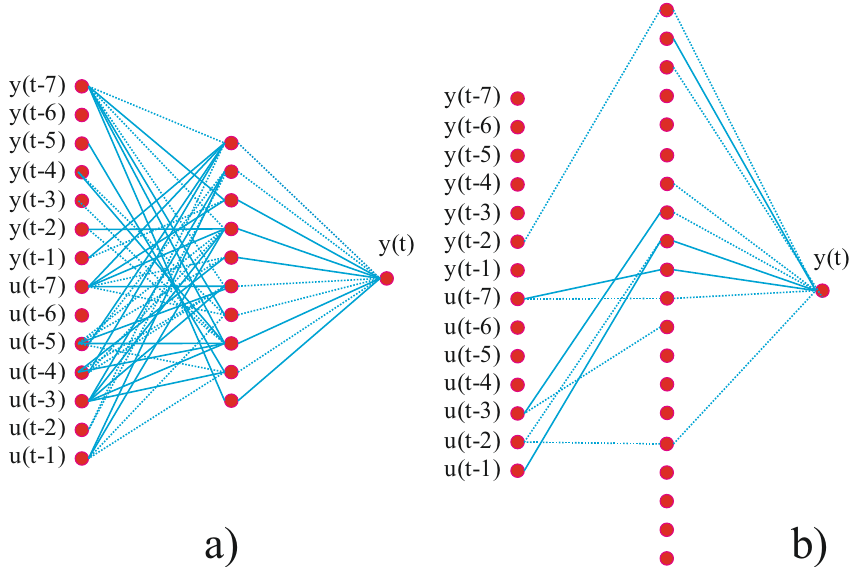
Fig. 3. Pruned structure of the feed forward neural network with the optimum number of connections: (a) solar irradiation and (b) wind speed.